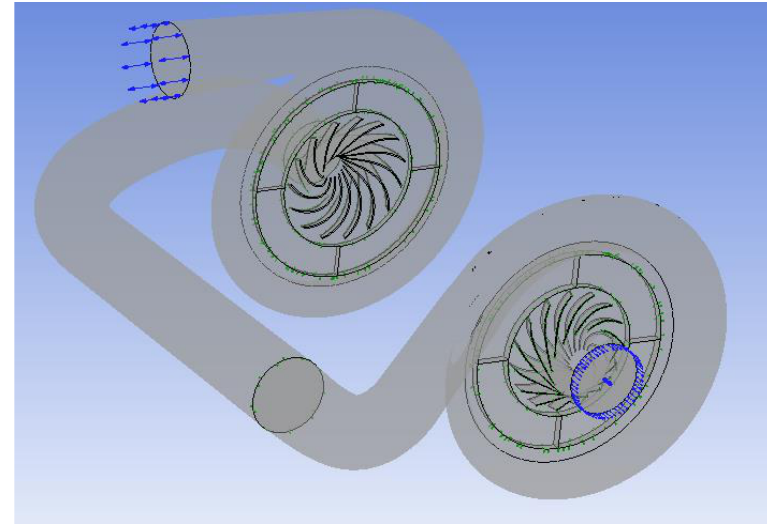
Figure 7. CFD model of the compressor.